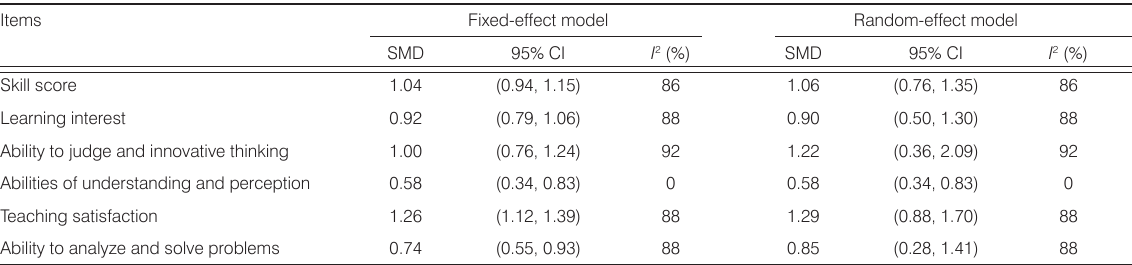
Table 5. Sensitivity